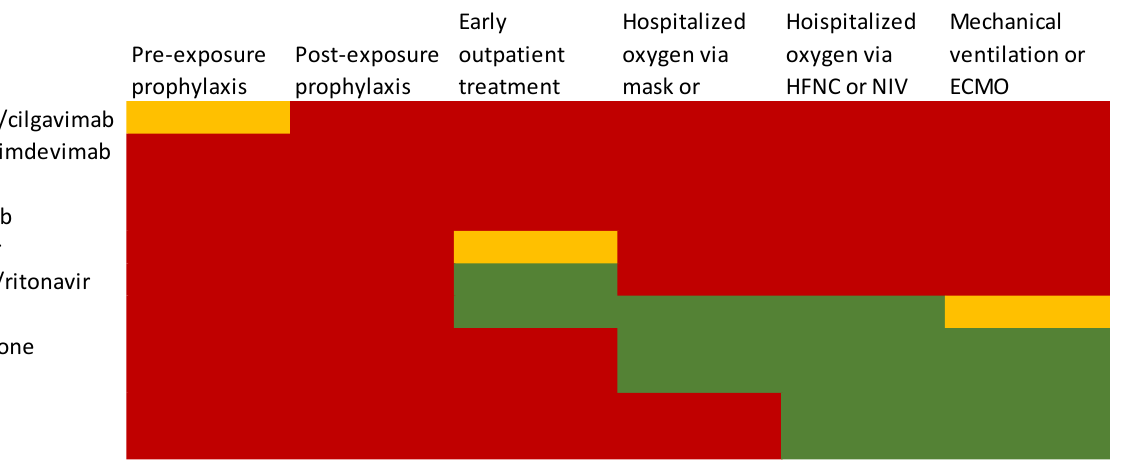
Figure 1. Current guidelines for the treatment of COVID-19. Red: this treatment is no longer recommended. Orange: this treatment is recommended lacking other options or in specific regions and populations. Green: this treatment is recommended for all patients.